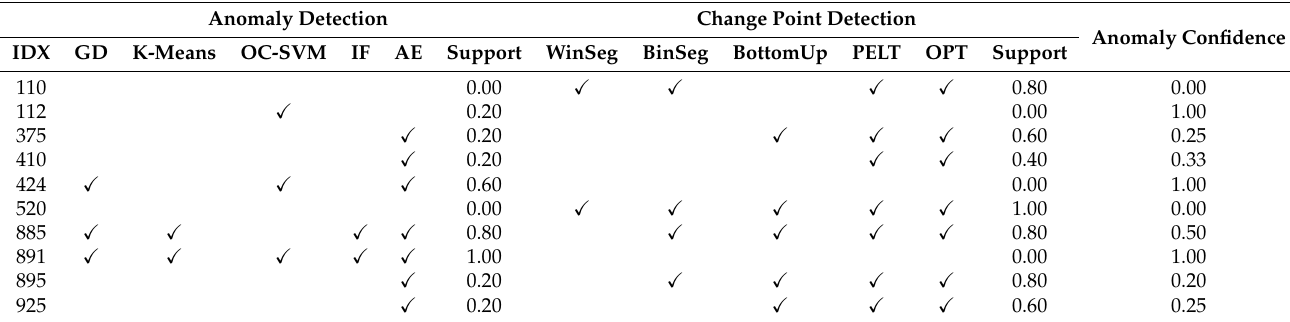
Table 3. Change Point enhanced Anomaly